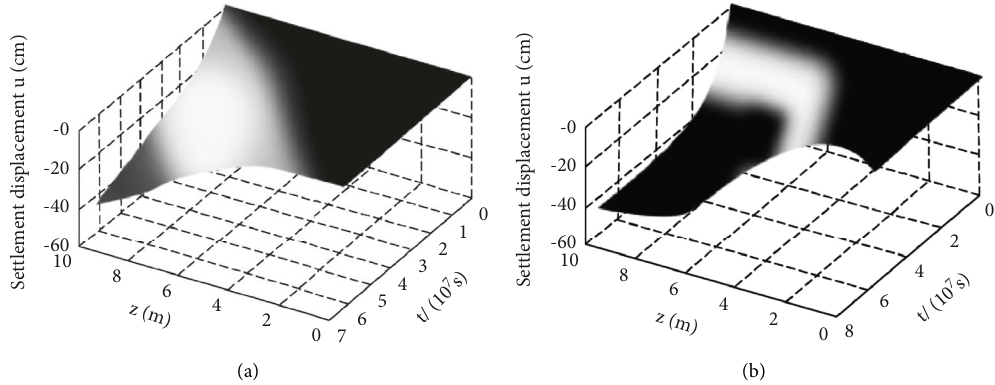
Figure 6: Calculation results of large deformation consolidation ( k � k